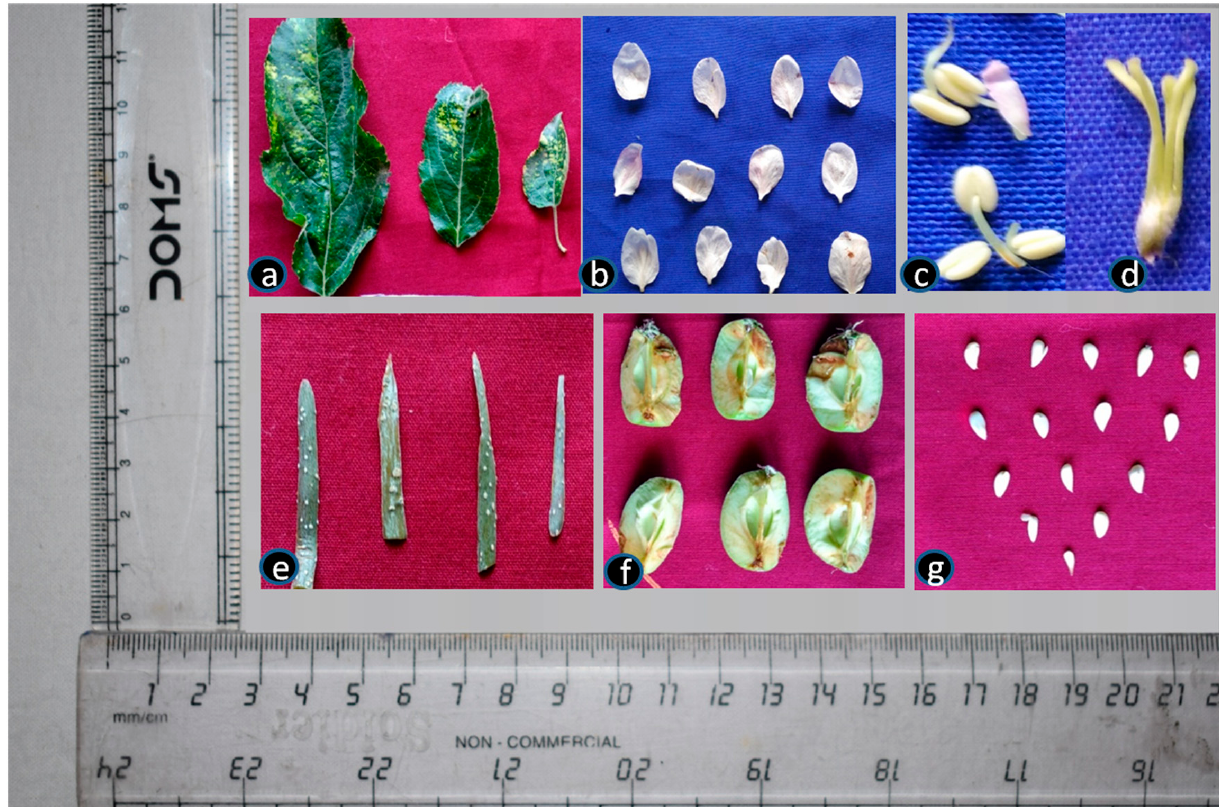
Figure 1. Different plant parts/tissues with presence or absence of symptoms noted for virus detection and quantification. ( a ) Symptomatic leaf and pedicel, ( b ) petals, ( c ) anther, ( d ) flowers without petal, ( e ) bark, ( f ) fruit and ( g ) seed.